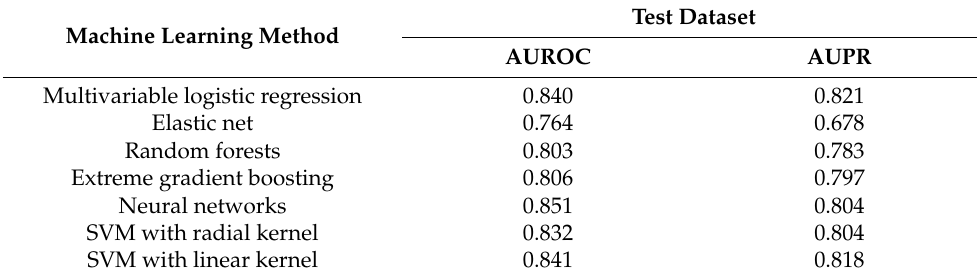
Table 2. Prediction performances of the trained machine learning models.